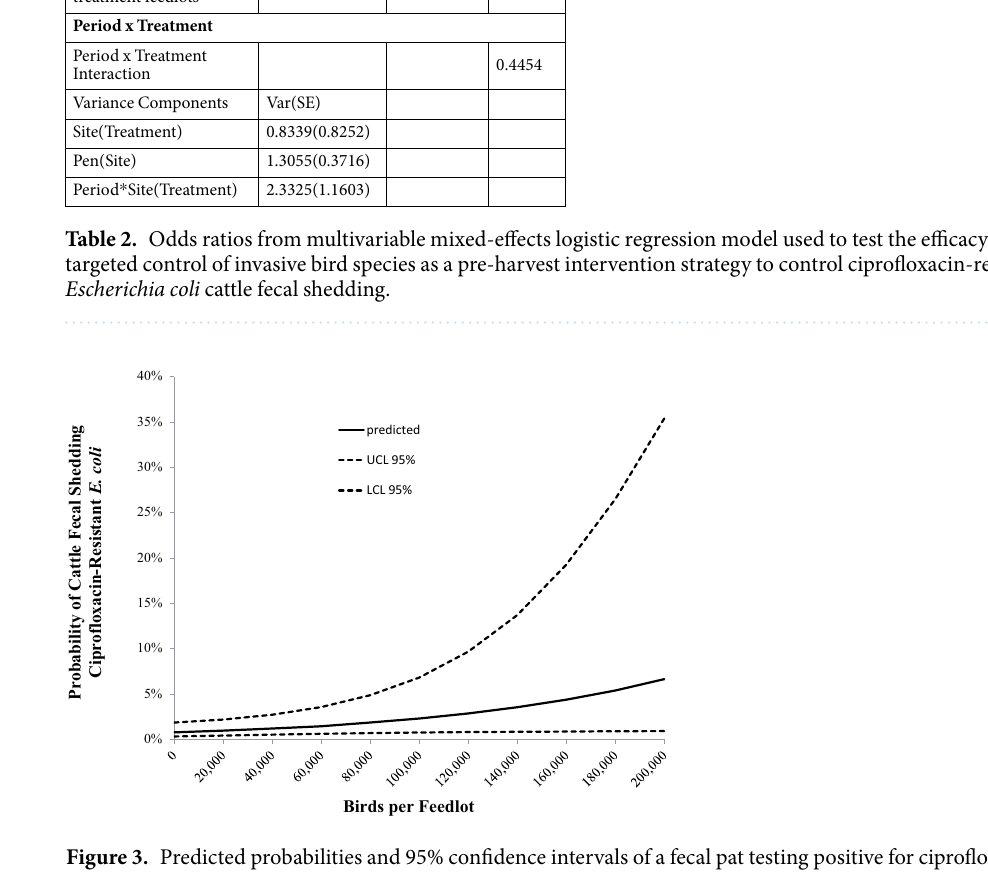
Figure 3. Predicted probabilities and 95% confidence intervals of a fecal pat testing positive for ciprofloxacin- resistant Escherichia coli as a function of bird numbers observed on feedlots within Texas, Colorado, Kansas, Missouri and Iowa between December 2012 and April 2013.